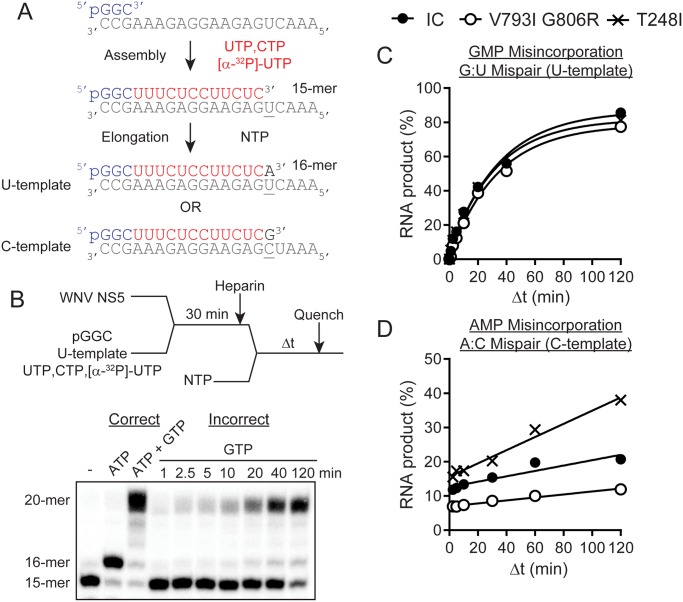
Evaluation of WNV NS5 variants with an in vitro primer extension assay reveals differences in polymerase incorporation fidelity.
A. Schematic of primer extension assay for evaluating WNV NS5 polymerase activity. B. Evaluation of elongation reactions using either correct or incorrect nucleotide substrates. Shown is the experimental design and denaturing PAGE gel of both correct and incorrect nucleotide addition. Experimental design: WNV NS5 is assembled for 30 min to produce elongation-competent complexes at which point a trap (heparin) for free enzyme is added. The reaction is then rapidly mixed with NTP substrate and quenched at various times. Denaturing PAGE gel: The 15-mer RNA is rapidly extended to 16-mer RNA product in the presence of correct nucleotide substrate, ATP. The presence of both ATP and GTP together promote full extension to 20-mer RNA as the terminal templating bases are competent for correct nucleotide addition. The presence of GTP alone allows for the kinetics of incorrect nucleotide incorporation to be observed (G:U mispair). C. Comparison of the kinetics of misincorporation between WNV-IC, V793I/G806R and T248I NS5. There is no observable difference in the kinetics of GMP misincorporation (G:U mispair). Shown is the percentage of RNA product plotted as a function of time and fit to a single exponential. D. By using an alternative substrate that allows for A:C mispairs to be evaluated, a difference in the efficiency of AMP misincorporation is observed between the three NS5 proteins.